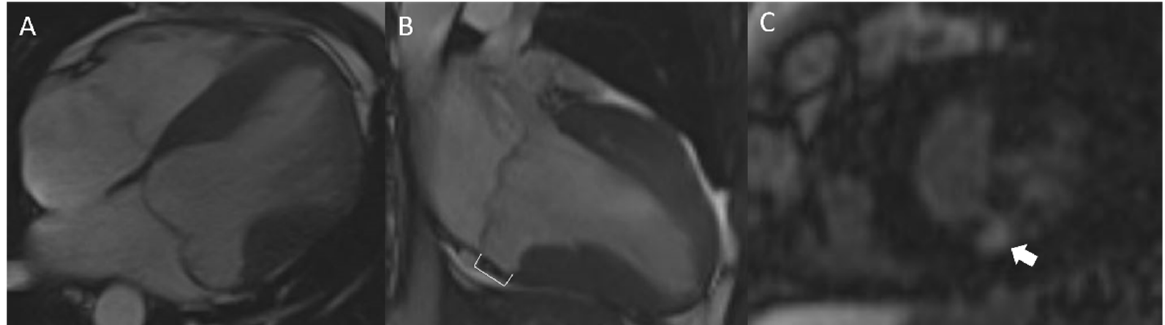
Figure 4. Cardiac magnetic resonance findings of arrhythmic mitral valve prolapse and